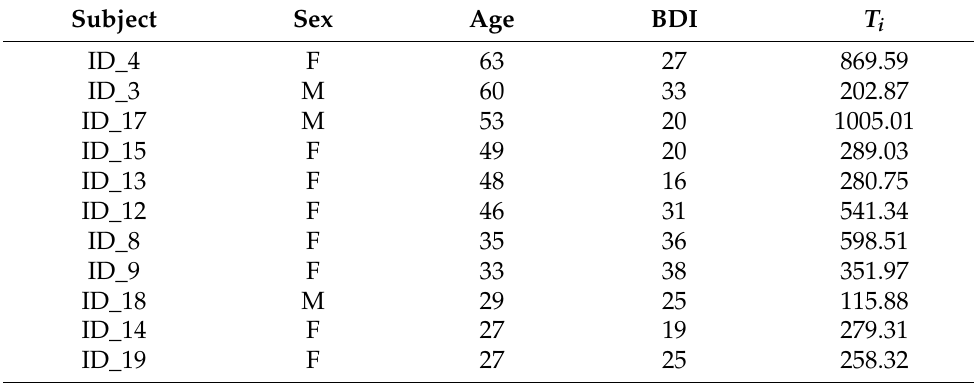
Table 2. Total variations ( T i ) in depressed subjects.